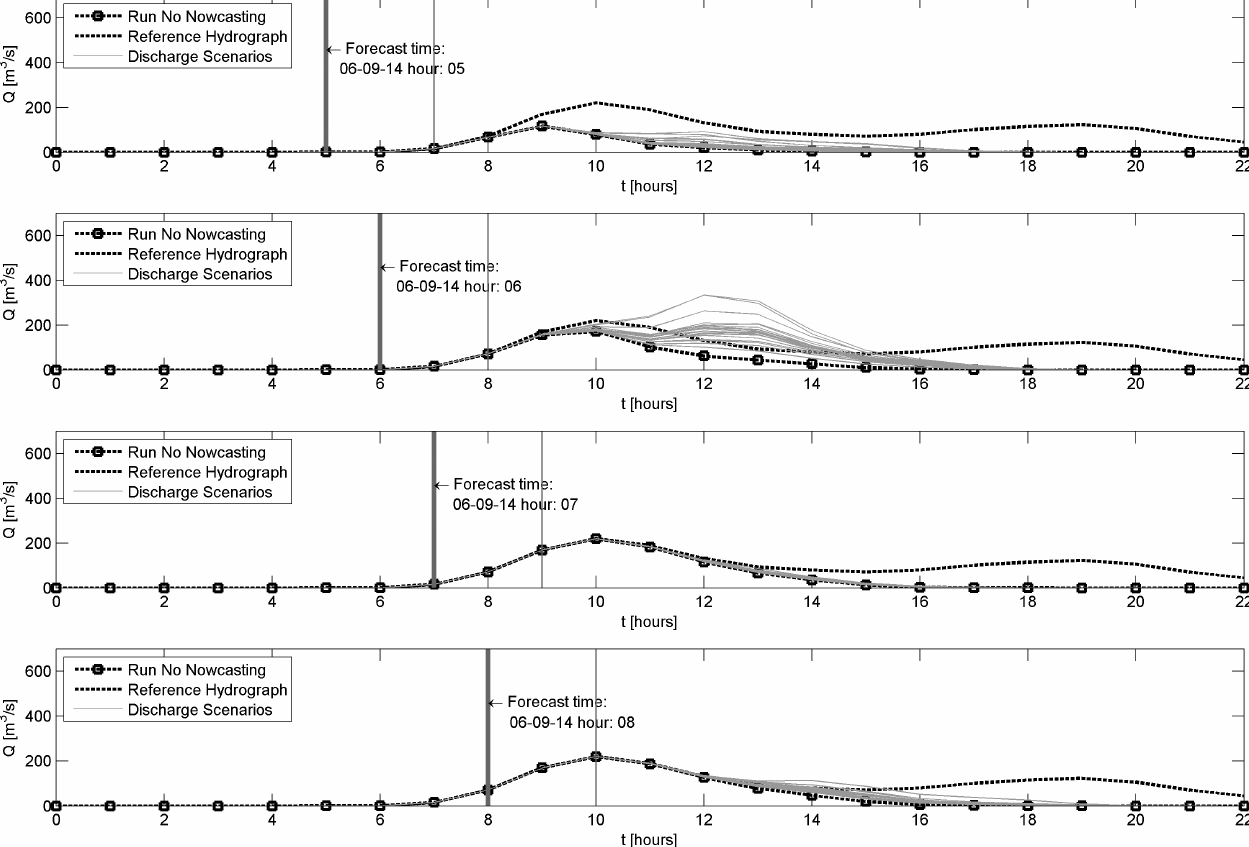
Fig. 6. Results of hydrological nowcasting framework for the Bormida basin closed at Valle Acna (Area = 243km 2 ) . The event on 14 Sep 2006 is shown. The thick grey vertical line represents the time of the last available observed field for each nowcasted scenario. The thin grey vertical line represents the end of nowcasting. The Run No Nowcasting is the discharge obtained feeding the rainfall-runoff model with observed rainfall